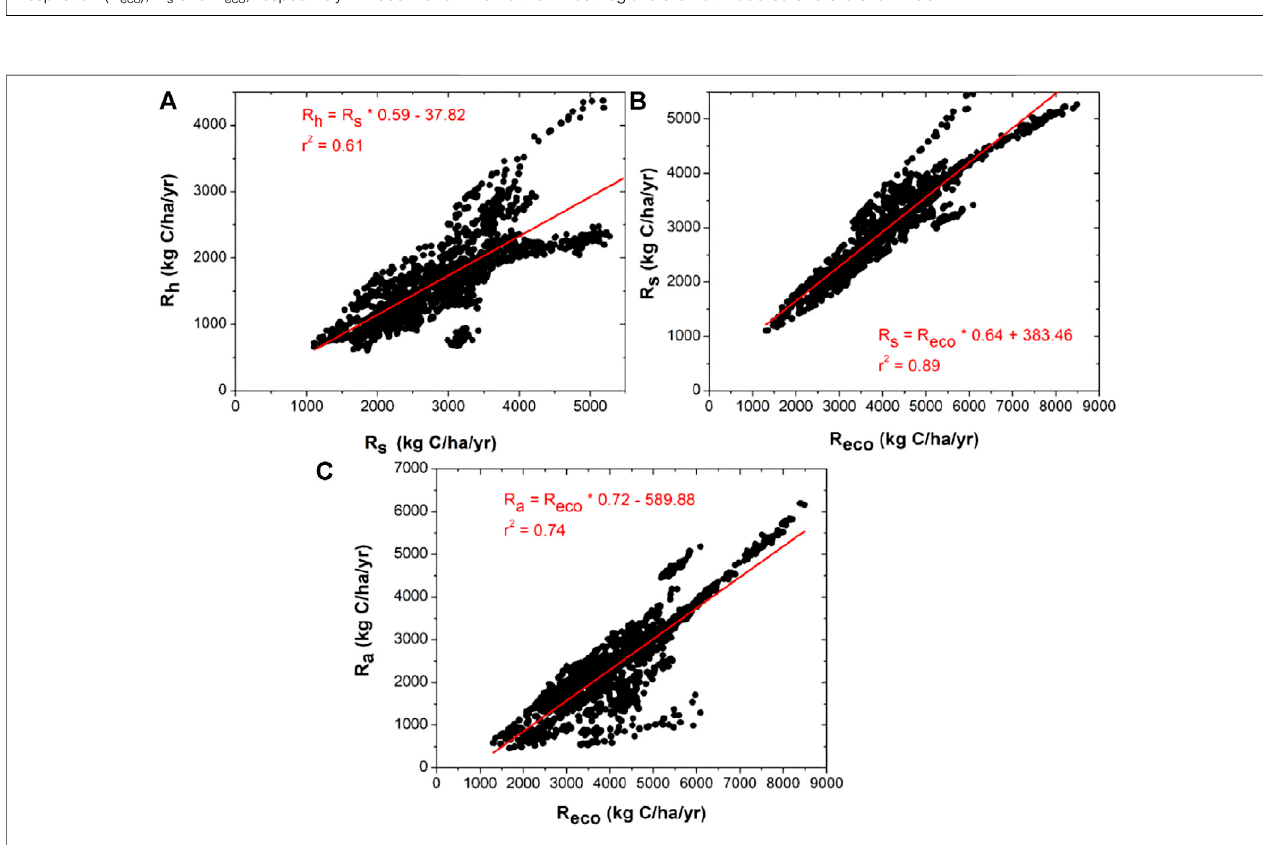
FIGURE 3 | Relationships between (A) annual mean soil heterotrophic respiration (R h ) and total soil respiration (R s ); (B) R s and ecosystem respiration (R eco ); (C) autotrophic respiration (R a ) and R eco ,